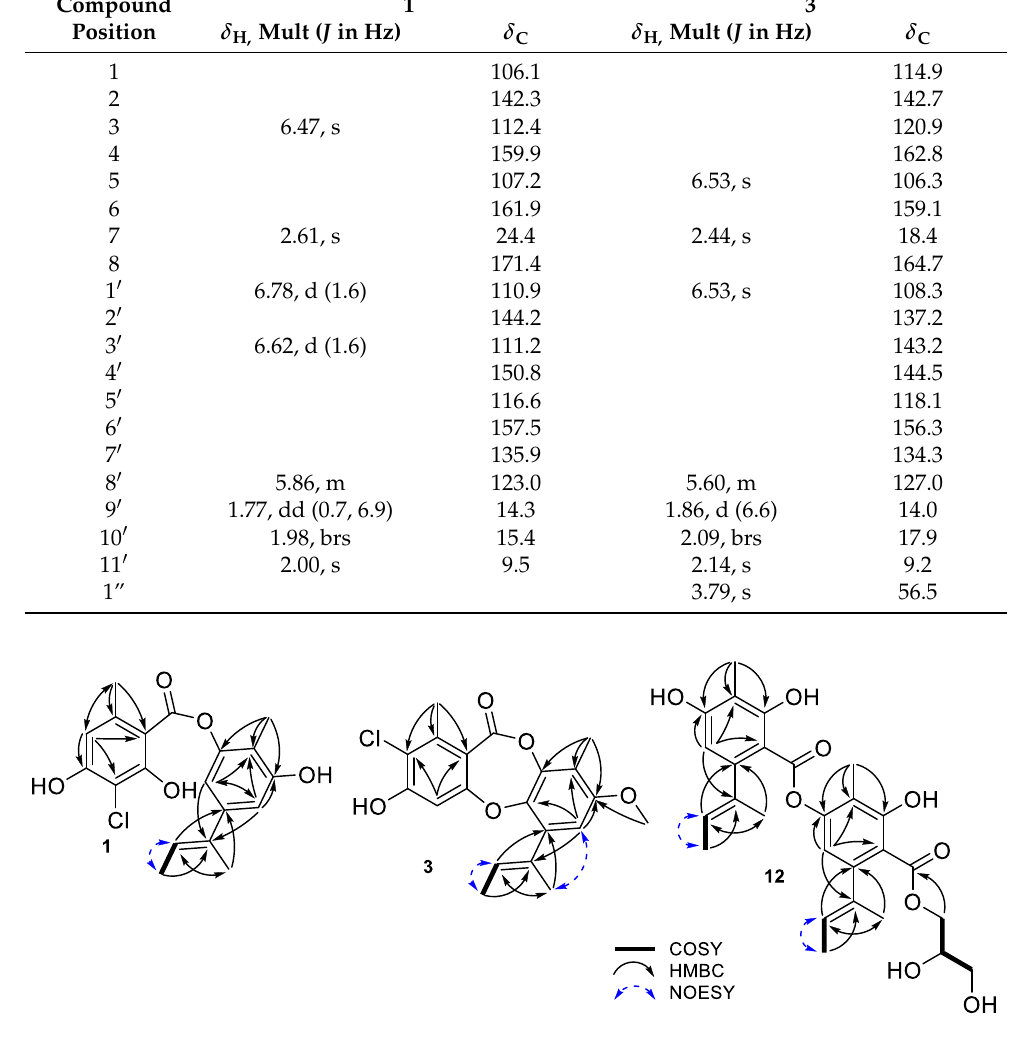
Figure 2. Key 2D NMR correlations of 1 , 3 , and 12 . Table 1. 1 H and 13 C NMR data of 1 and 3 in CD 3 OD (600 MHz for 1 H and 150 MHz for 13 C). Compound 3 was purified as a colorless solid. The HRESIMS peaks [M + Na] + of 3 were observed at m / z 397.0818 and 399.0795 with a ratio of 3: 1, determining the molecular formula of 3 as C 20 H 19 ClO 5 (calculated for C 20 H 19 ClO 5 Na, 397.0819, Figure S10),